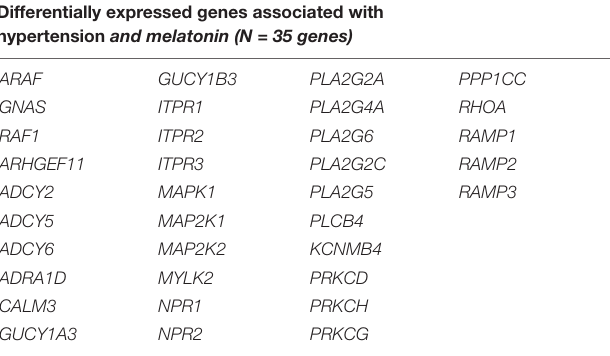
TABLE 4 | Correlation of vascular smooth muscle contraction pathways modified by hypertension and melatonin